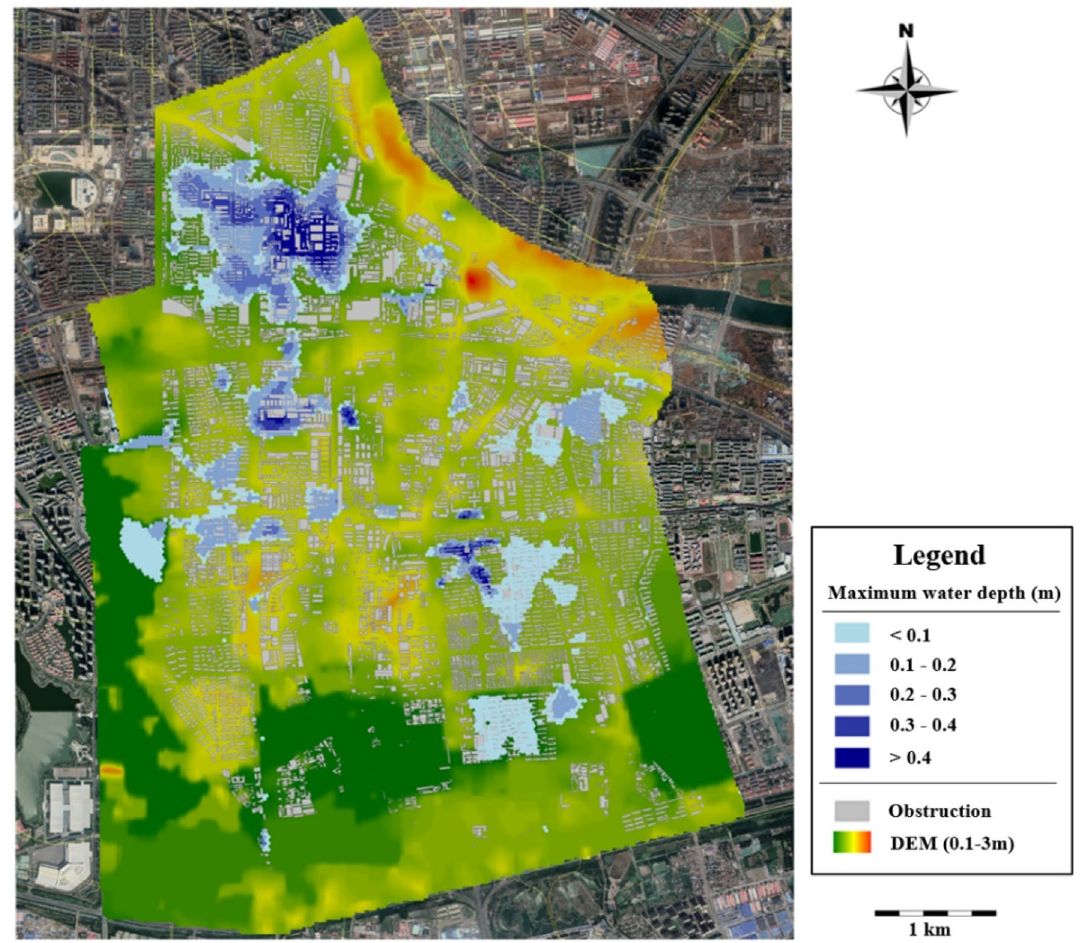
Fig. 6 Results of flooding in the study area on Jiefang South Road in Tianjin Municipality, China (the maximum water depth [ 0.05